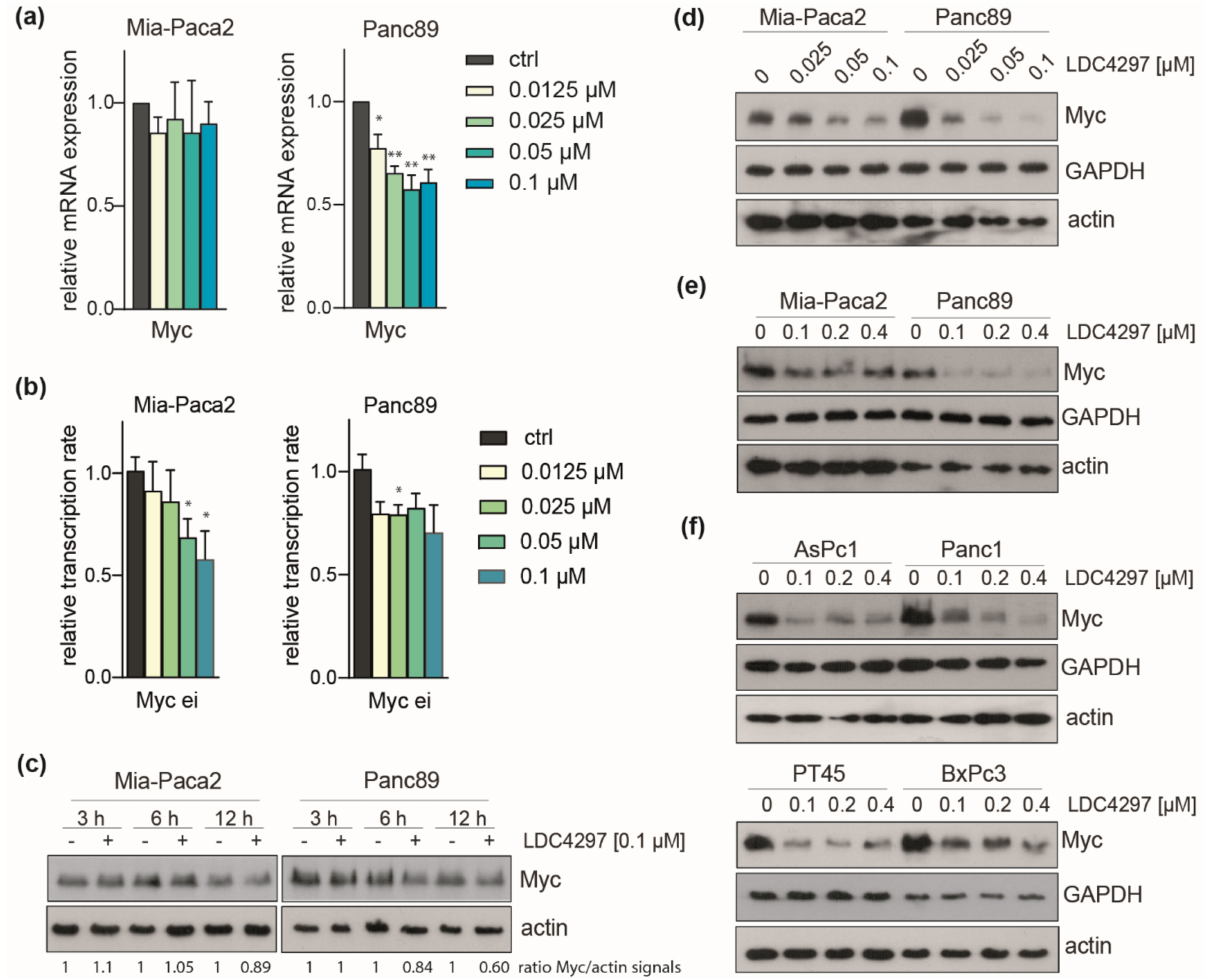
Figure 6. CDK7 inhibition causes downregulation of Myc in PDAC lines. ( a ) Analysis of Myc mRNA expression by RT-qPCR in Panc89 and Mia-Paca2 cells treated with the indicated concentra- tions of LDC4297 for 3 days. Shown is the mean ± SD ( n = 4). ( b ) Analysis of Myc transcription rate by RT-qPCR using Myc ei primers in Mia-Paca2 and Panc89 cells treated with the indicated concentrations of LDC4297 for 2 h. Shown is the mean ± SD ( n = 3). ( c ) Immunoblot analysis of Myc protein level in Mia-Paca2 and Panc89 cells treated with 0.1 µ M LDC4297 for the indicated times. ( d , e ) Immunoblot analysis of Myc protein level in Mia-Paca2 and Panc89 cells treated with the indicated concentrations of LDC4297 for 4 days. ( f ) Immunoblot analysis of Myc protein level in AsPc1, Panc1, PT45 and BxPc3 cells treated with the indicated concentrations of LDC4297 for 4 days. Significance was analyzed by two-sided Student’s t test: * p ≤ 0.05; ** p ≤